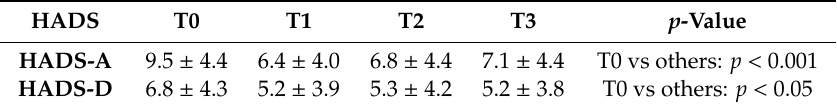
Table 5. Hospital Anxiety and Depression Scale (HADS) at T0, T1, T2 and T3. The reported results refer to the 41 patients evaluated at T3. A: Anxiety, D: